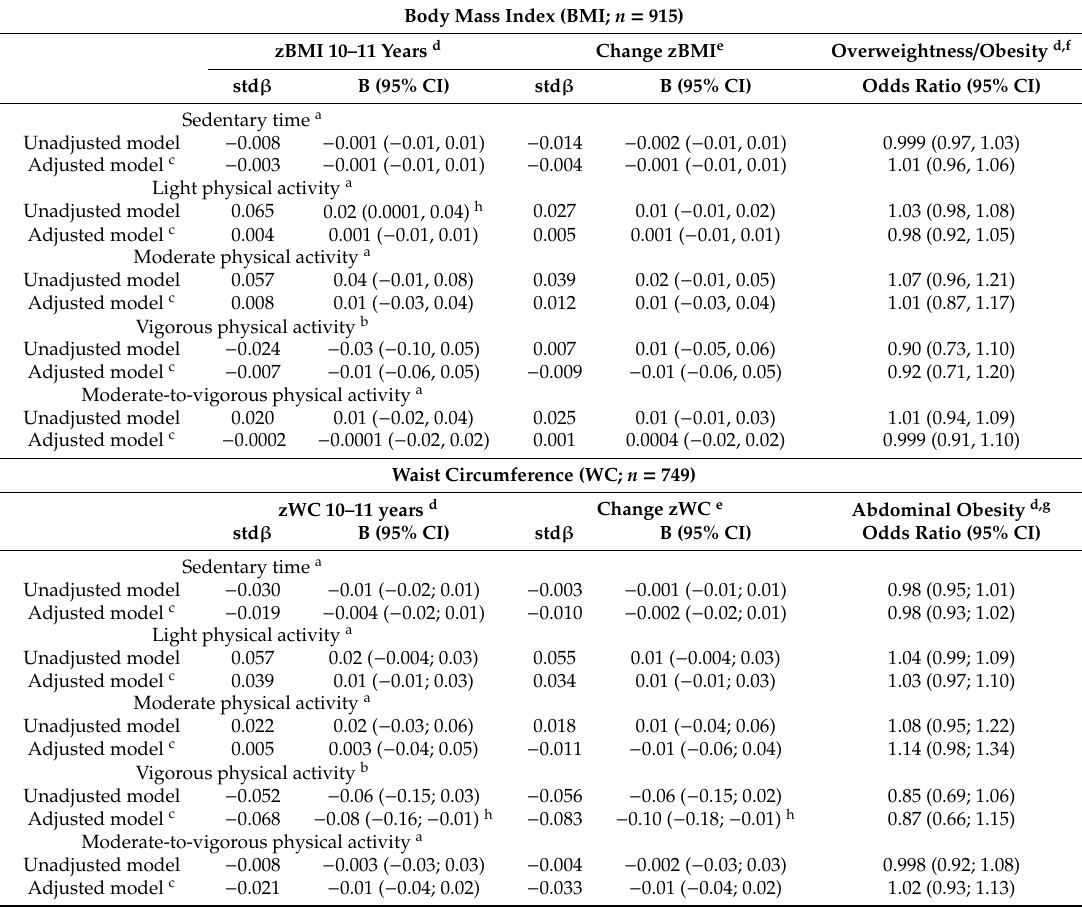
Table 3. Prospective associations of physical activity behaviours with